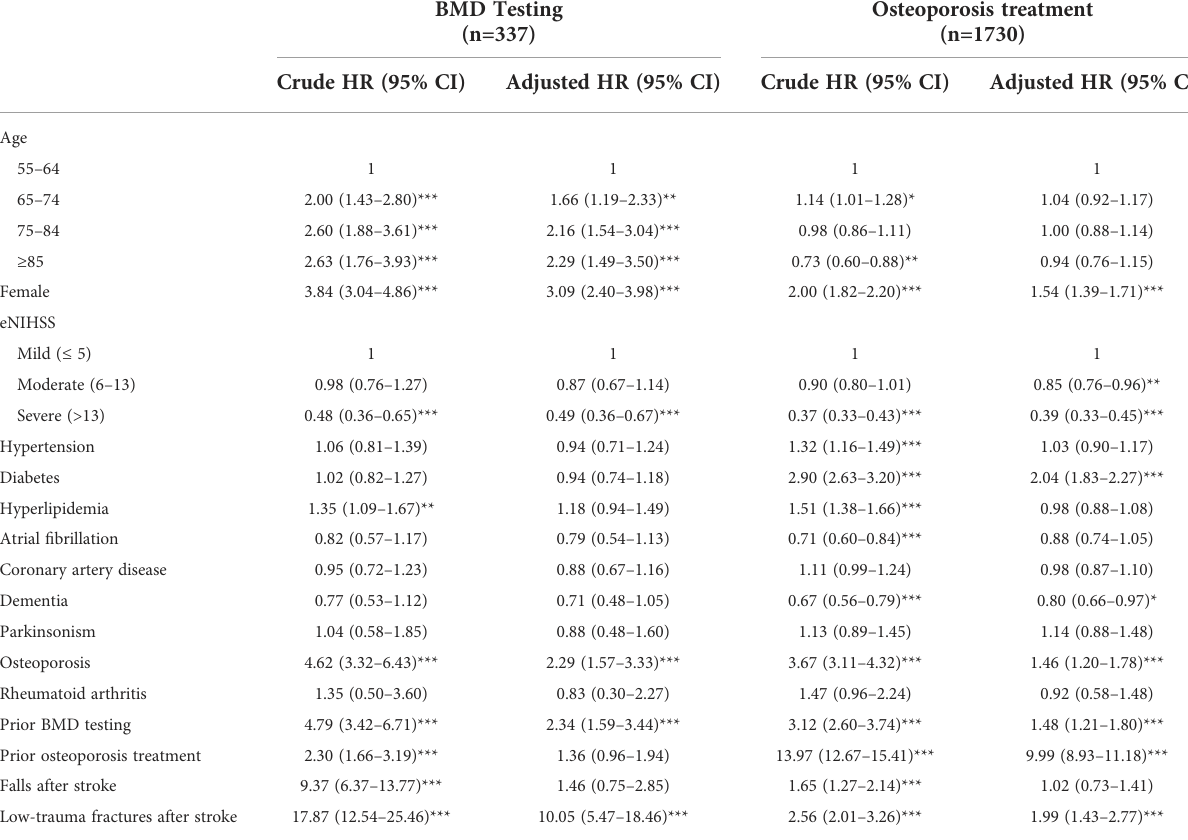
TABLE 2 Predictors of BMD testing and osteoporosis treatment among stroke